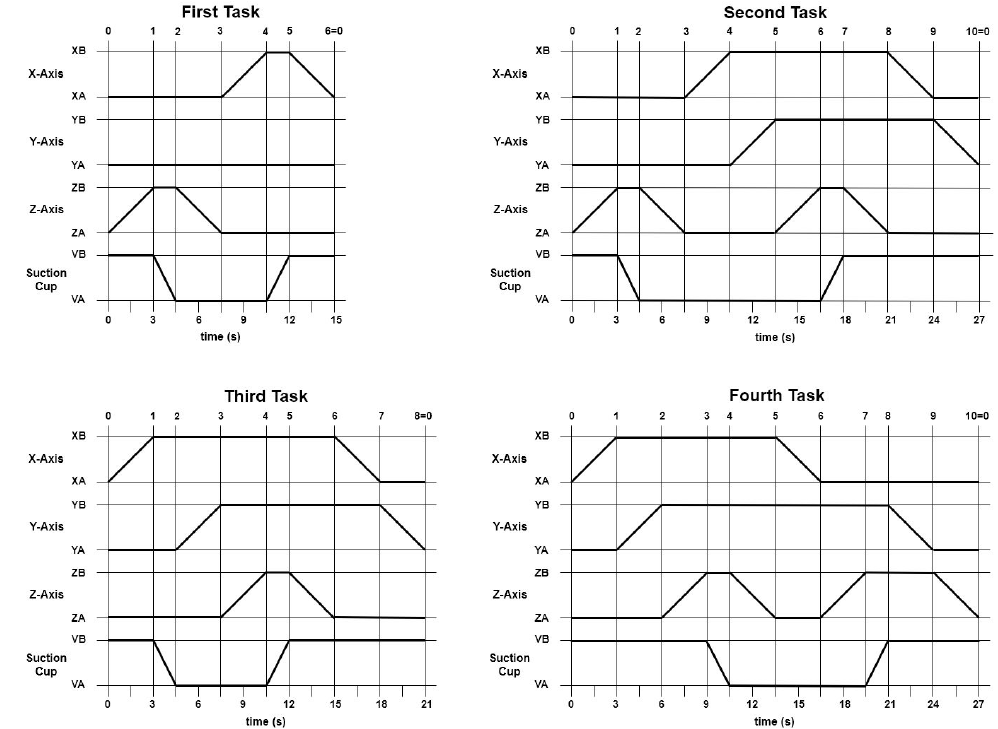
Figure 8. Displacement–time diagrams showing the sequences performed by each actuator during each of the four tasks defined in the Specification. Times are approximated, obtained by visual